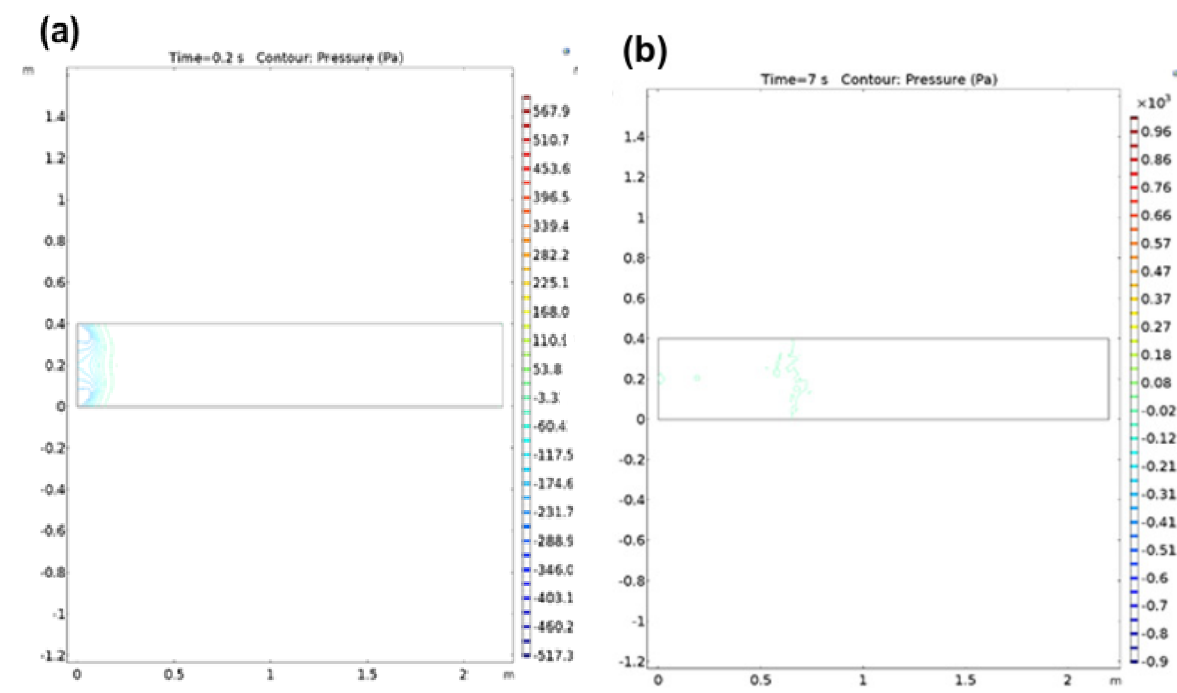
Figure 9. Scheme of the contour pressure ( a ) at lower and ( b ) higher time range for isotropic particle distribution in the polymer matrix.